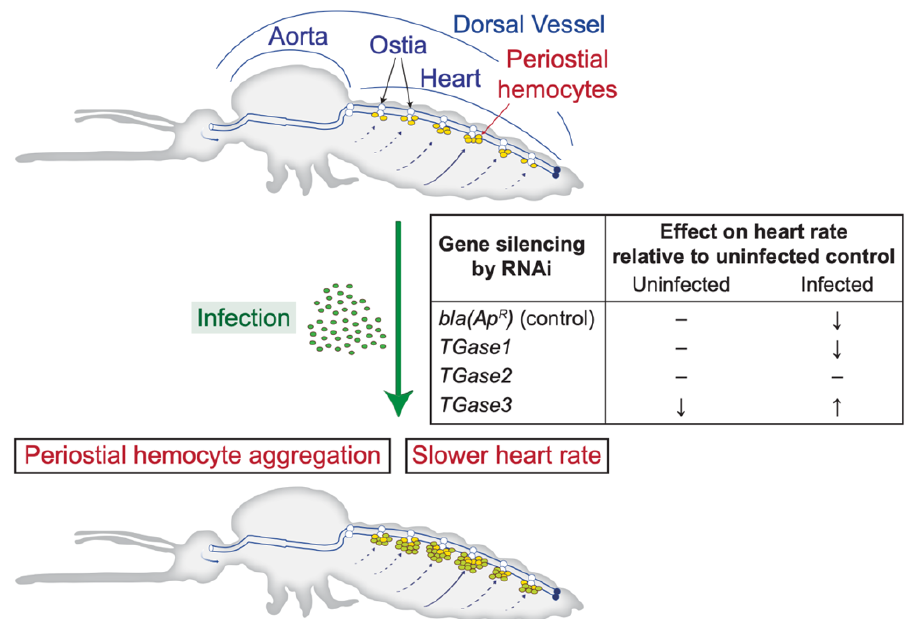
Figure 4. Diagrammatic representation of the mosquito circulatory system and the process of periostial hemocyte aggregation, together with the effect of silencing transglutaminase genes on the heart contraction rate of uninfected and infected mosquitoes.